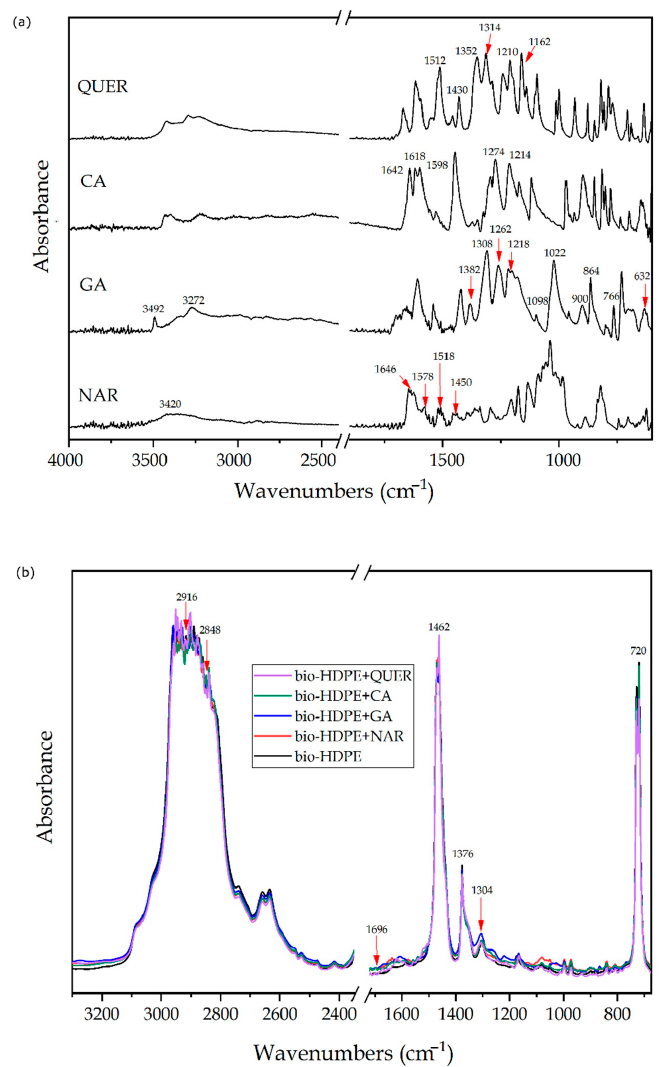
Figure 5. Fourier transform infrared (FTIR) spectra of: ( a ) natural antioxidants in powder form of, from bottom to top, naringin (NAR), gallic acid (GA), caffeic acid (CA), and quercetin (QUER); ( b ) thermo-compressed bio-based high-density polyethylene (bio-HDPE) films containing NAR, GA, CA, and QUER.